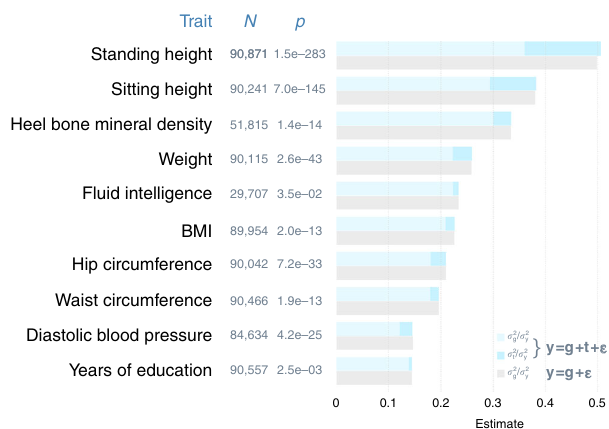
Fig. 1 Imputed transcriptome contributes to phenotypic variance. Shown are estimated variance components as a proportion of total phenotypic variance from a linear mixed model that includes the random effects of the imputed transcriptome and another model that does not, denoted as y = g + t + ε and y = g + ε , respectively. N = sample size; p = p -values from likelihood ratio tests (df = 1) that compare the two models to detect signi fi cant effects of the imputed transcriptome. g = the random effects of the genome; t = the random effects of the imputed = phenotypic variance explained by the transcriptome; ε = residuals; σ 2 t = phenotypic variance explained by the genome; imputed transcriptome; σ 2 g σ 2 = total phenotypic variance. The imputed transcriptome consists of y expression levels of 227,664 genes from 43 non-sex-speci fi c tissues. Source data are provided as a Source Data fi